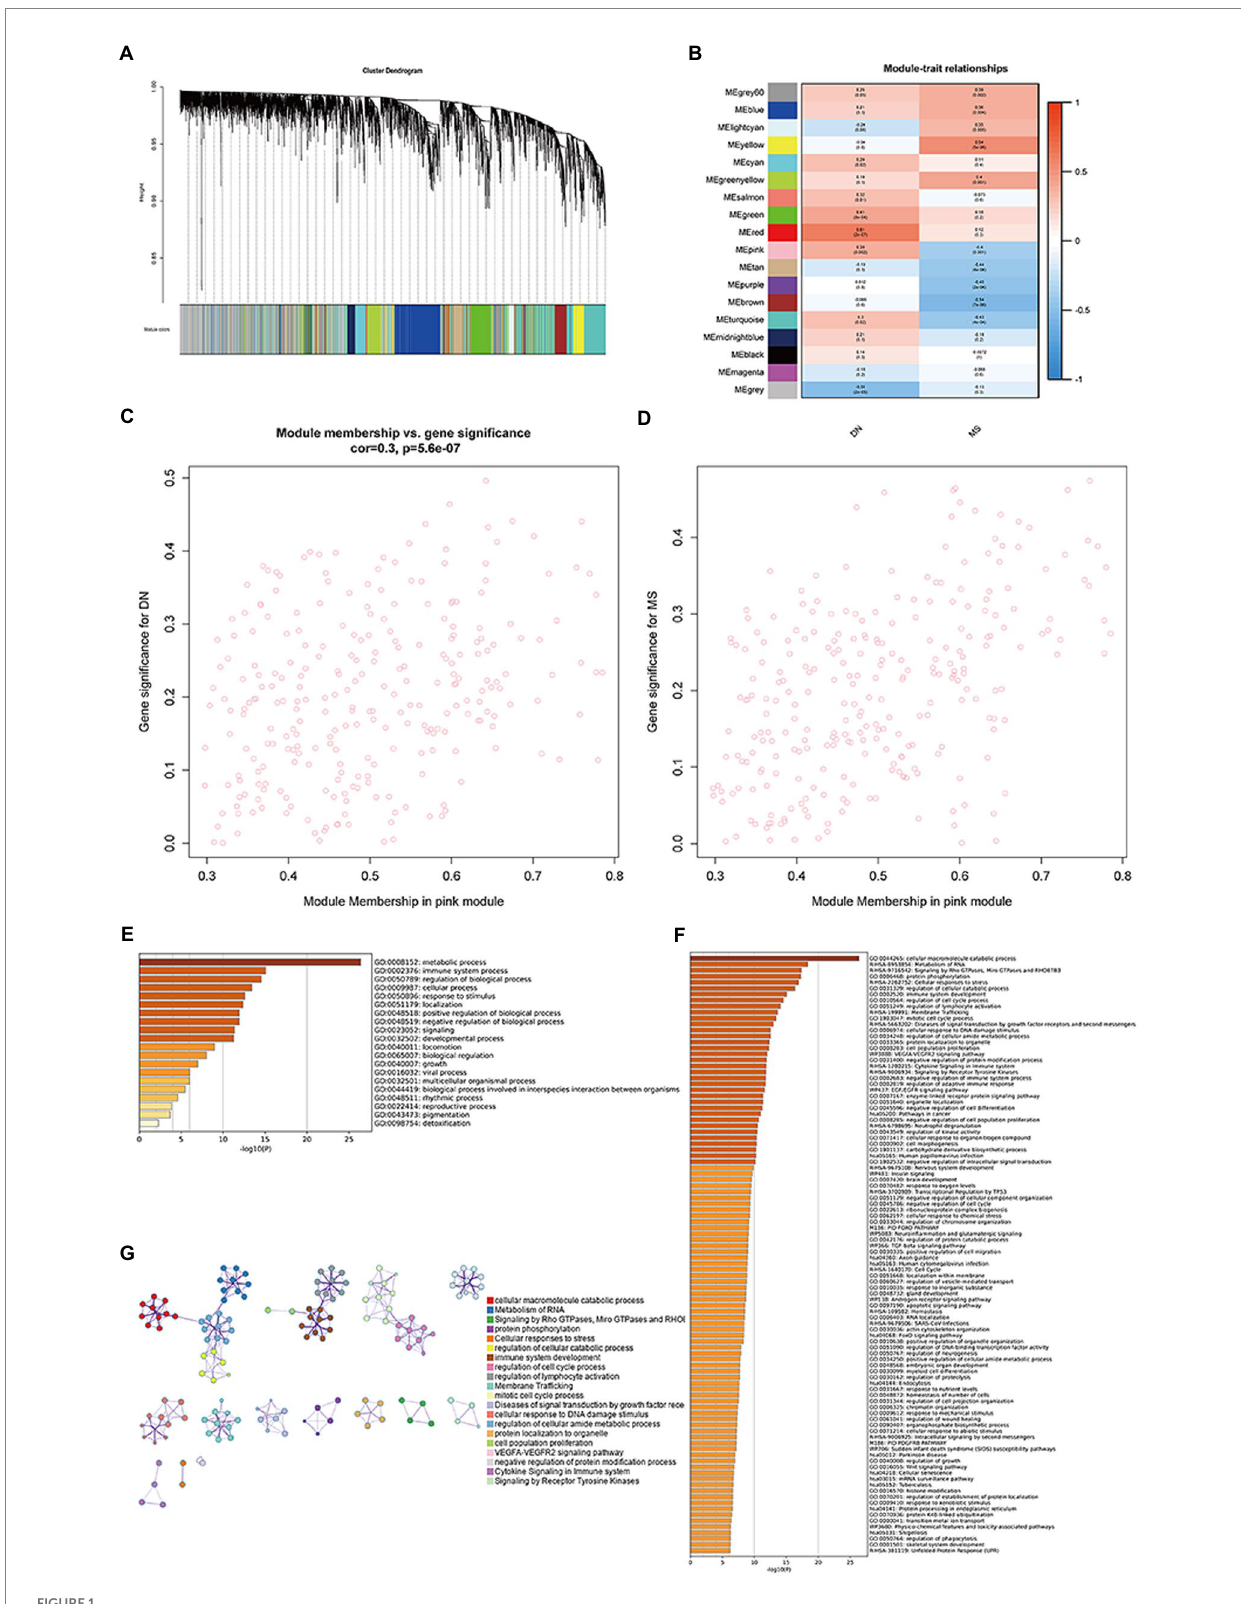
FIGURE 1 Co-expression modules in DN and MS. (A) Clustered dendrogram of genes. Each branch in the figure represents a gene, while each color below represents a co-expression module. (B) Heatmap of module-feature relationships. The pink module was significantly associated with DN. (C) Distribution of mean gene significance in modules associated with DN ( p = 5.6e − 07). (D) Distribution of mean gene significance in modules associated with MetS ( p = 7.5e − 17). (E) The top-level Gene Ontology biological processes. (F) Up to 100 enriched clusters. (G) Network of enriched terms: colored by cluster ID, where nodes that share the same cluster ID are typically close to each